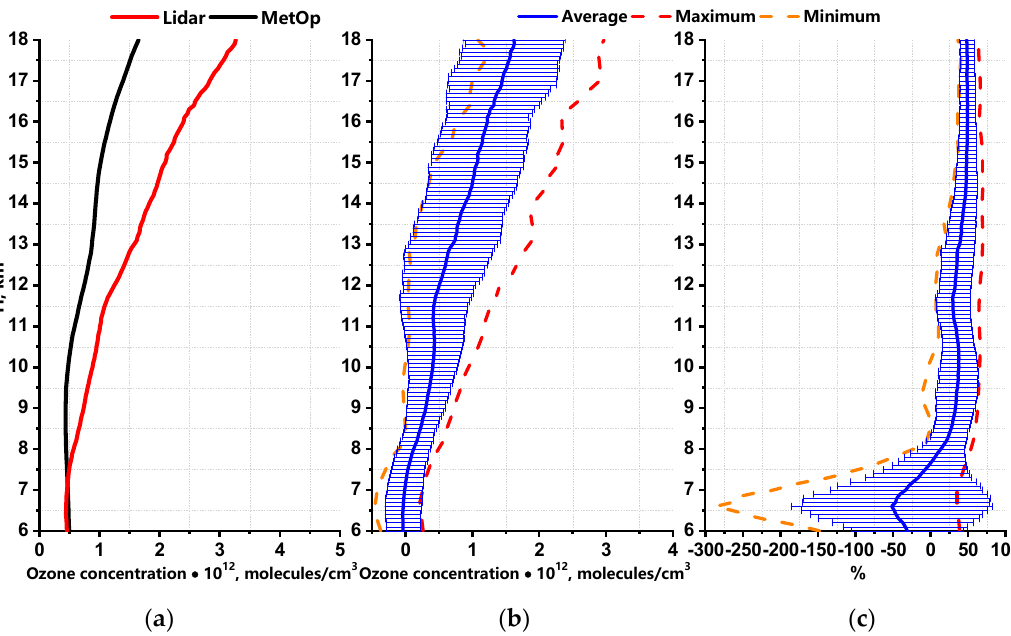
Figure 9. Average OVDs for season of summer–fall and their differences: ( a ) average profiles; ( b ) differences between the lidar and MetOp data, in absolute units; and ( c ) relative differences 100 × (lidar − MetOp )/lidar.